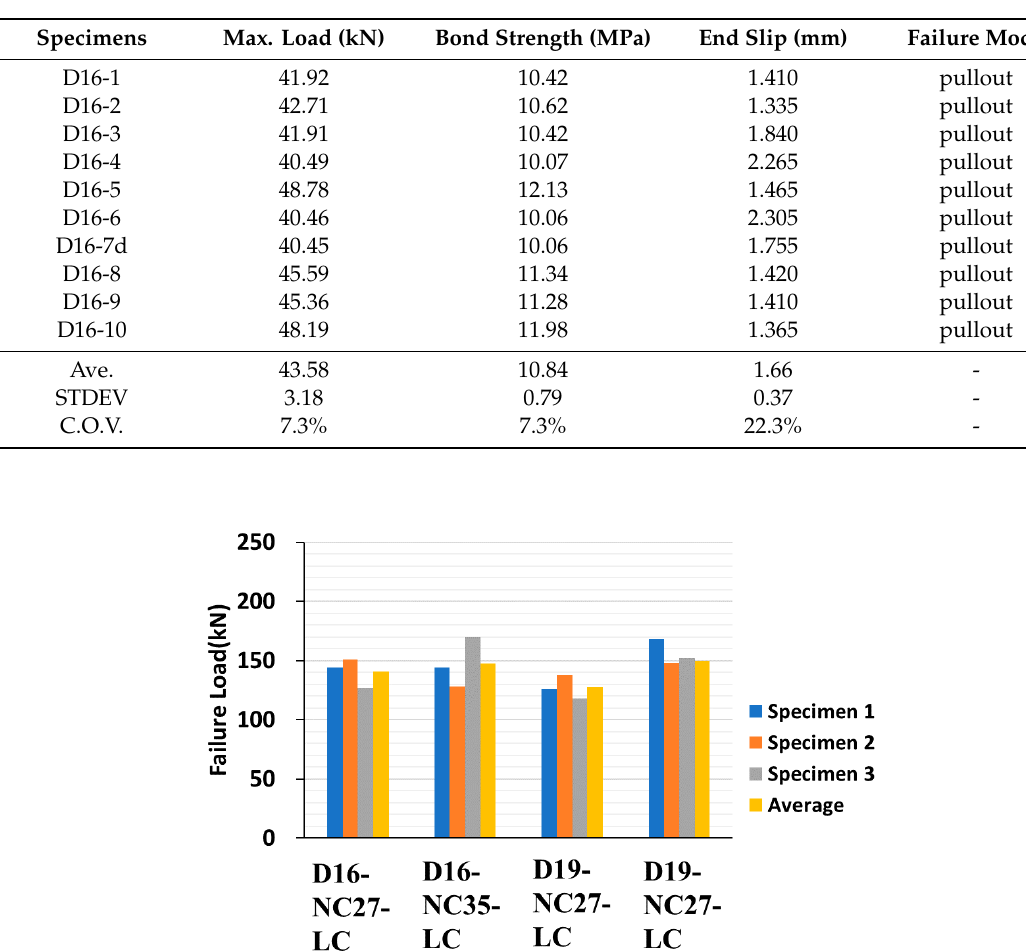
Table 5. Test results of the pull-out test (D16 GFRP rebars, normal concrete).